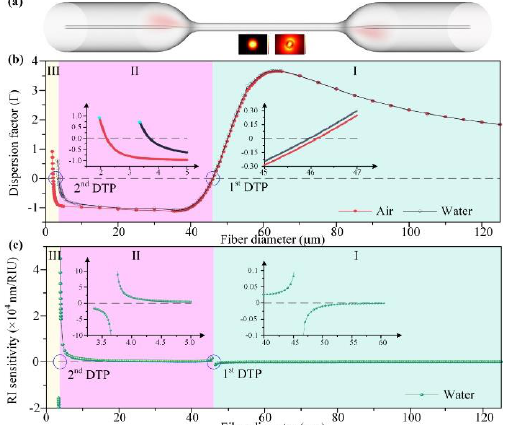
Figure 8. ( a ) Schematic diagram of the taper-based in-line MZI; the inset presents calculated intensity profiles of the interference two modes, HE 11 and HE 12 , respectively; ( b ) simulated dispersion factor Γ and ( c ) RI sensitivity as functions of the fiber diameter. Adapted with permission from Ref. [29].